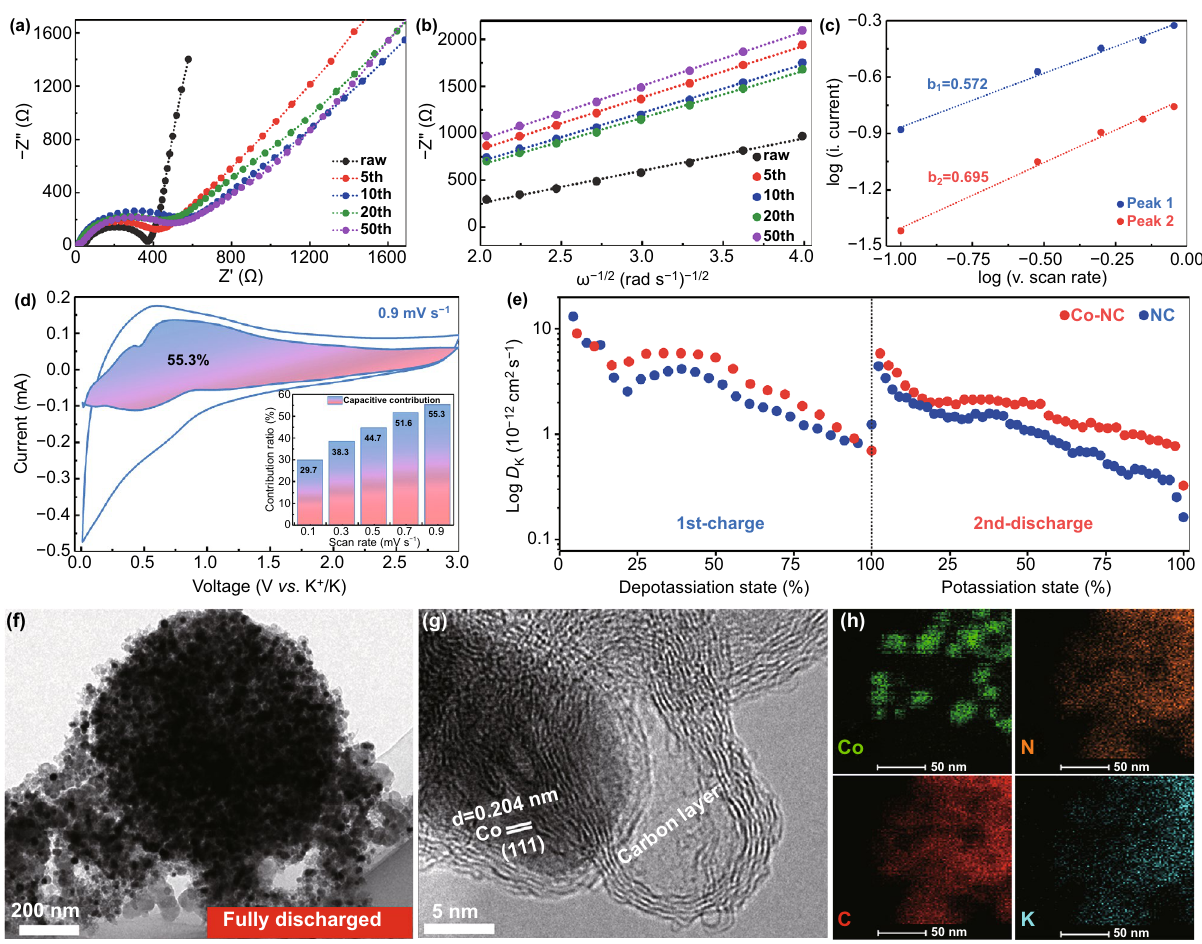
Fig. 3 a Nyquist plots and b fitted linear ω − 1/2 versus Z ″ curves of Co-NC electrode after 0, 5, 10, 20, and 50 cycles; c corresponding log( i ) vs. log( v ) plots at specific peak currents; d capacitive contribution percentage at different scan rates and CV curve with capacitive fraction at 0.9 mV s −1 scan rate of Co-NC electrode; e GITT results of NC and Co-NC electrodes treated at 50 mA g −1 ; f TEM, g HRTEM, and h mapping images of Co-NC electrode at a fully discharged